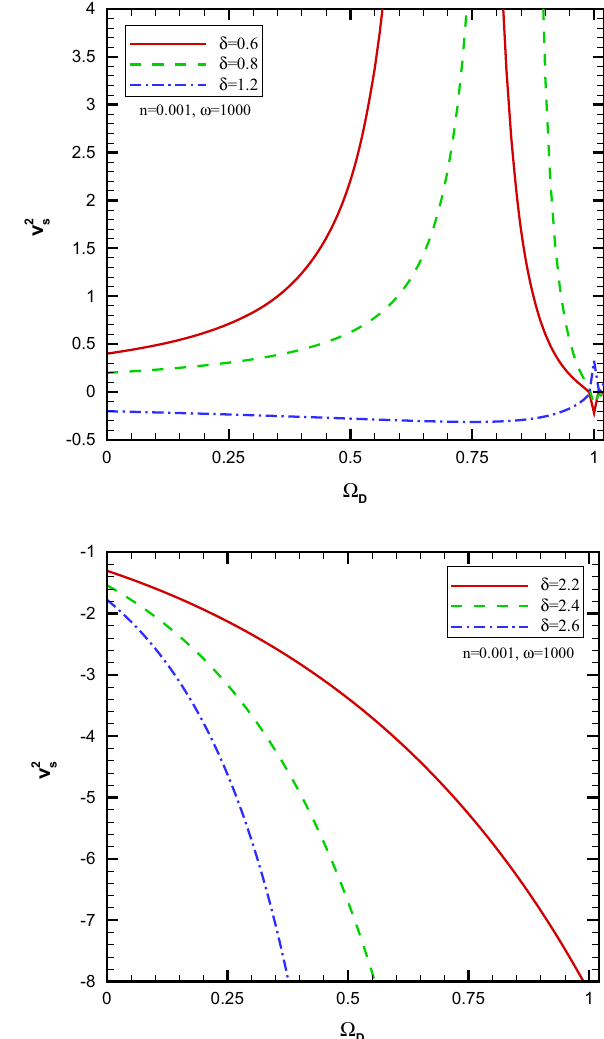
Fig. 8 v 2 s versus z for the non-interacting THDE in the BD gravity, where (cid:3) k = 0 (upper panel), (cid:3) k 0 = 0 . 1 (lower panel), n = 0 . 001 and ω = 1000 [19] are